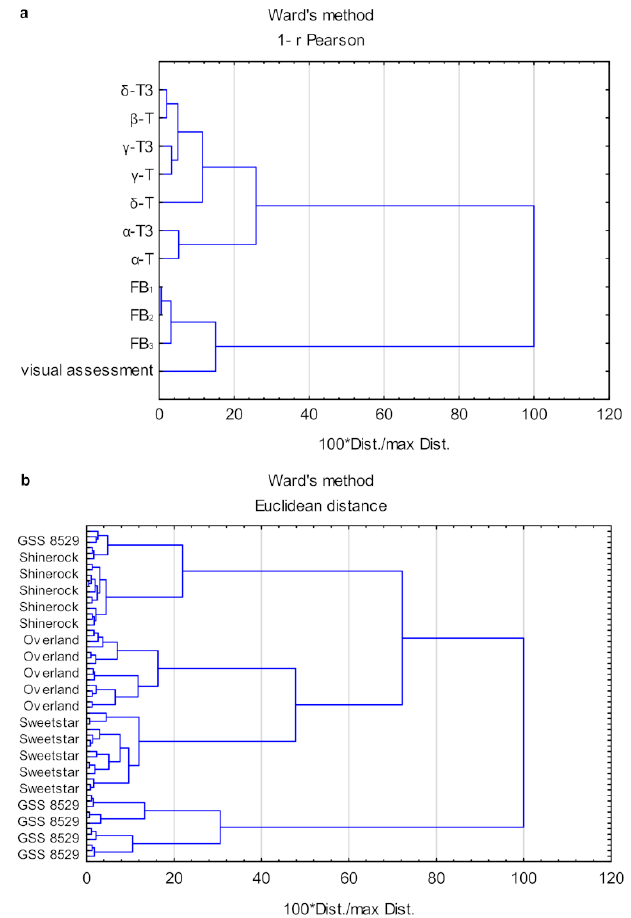
Figure 4. Dendrograms of variables ( a ) and scores–maize variety ( b ) of CA (cluster analysis) of